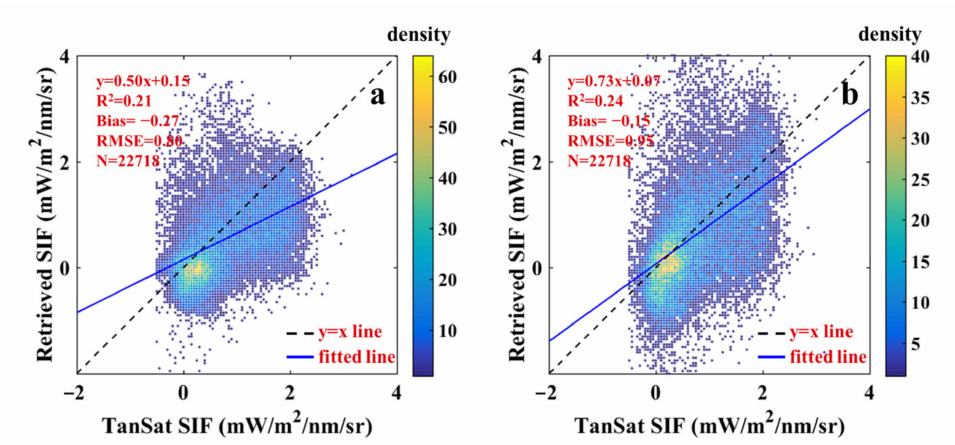
Figure 10. Scatter plot of SIF retrievals and TanSat SIF with different spectral windows: 769.5–776 nm ( a ) and 769.5–778 nm ( b ). The color legend indicates the density of scattered